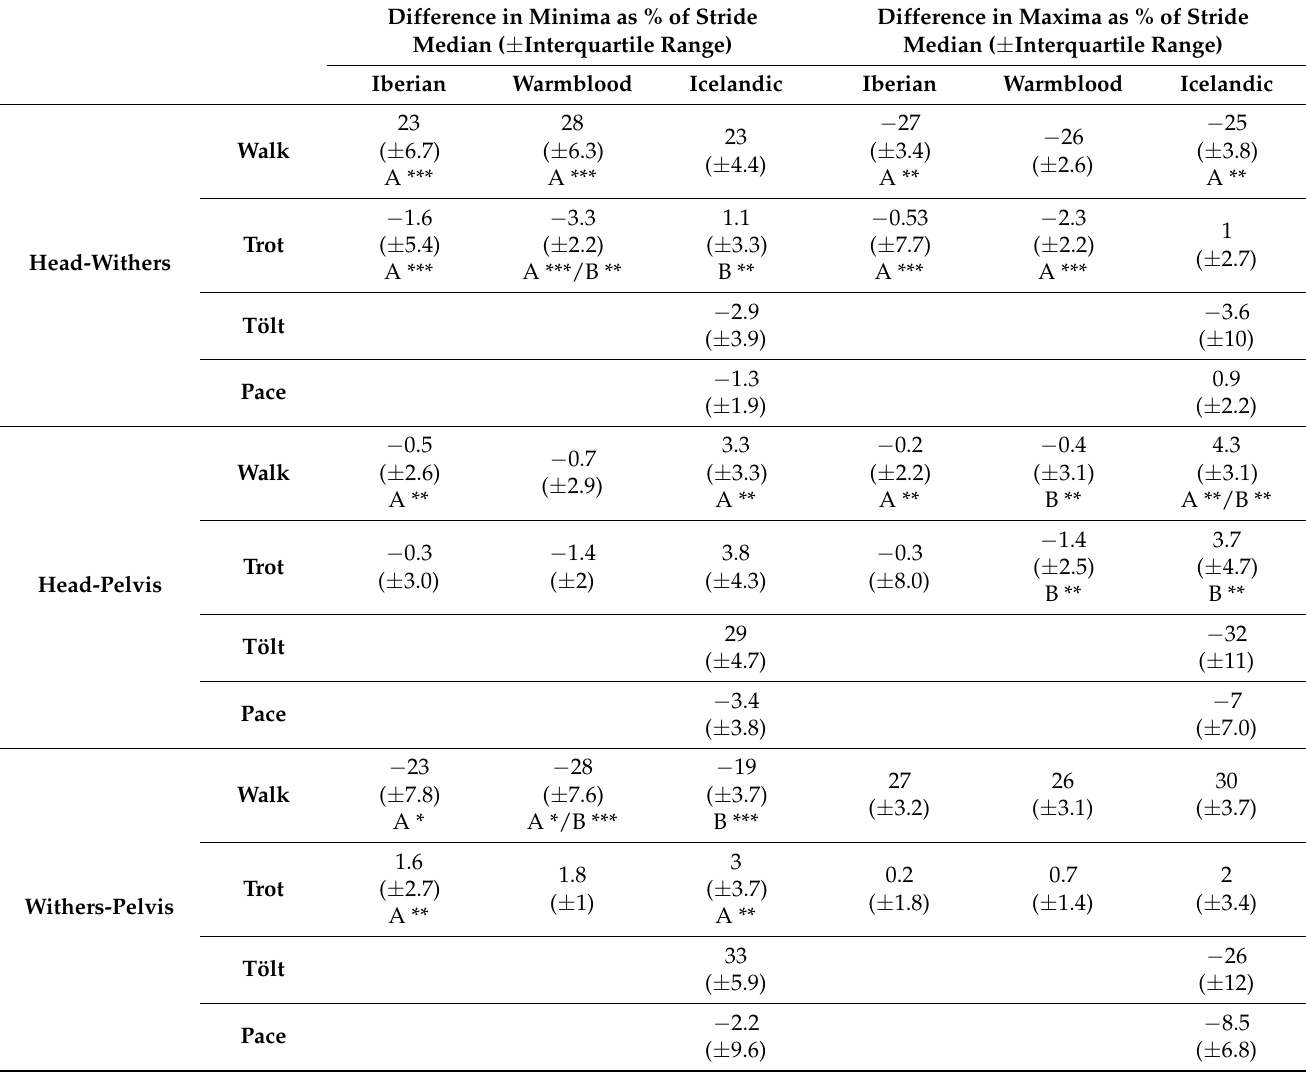
Table 5. Difference in timing of vertical minima and maxima between different axial body segments (head–withers, head–pelvis, withers–pelvis) in Iberian, Warmblood, and Icelandic horses performing different gaits. Significant differences in pair-wise comparisons between breeds are indicated by the same letters (A, B) and asterisks indicating the level of significance (* p < 0.05, ** p < 0.01, *** p < 0.001). Difference in Minima as % of Stride Difference in Maxima as % of Median ( ± Interquartile Range)